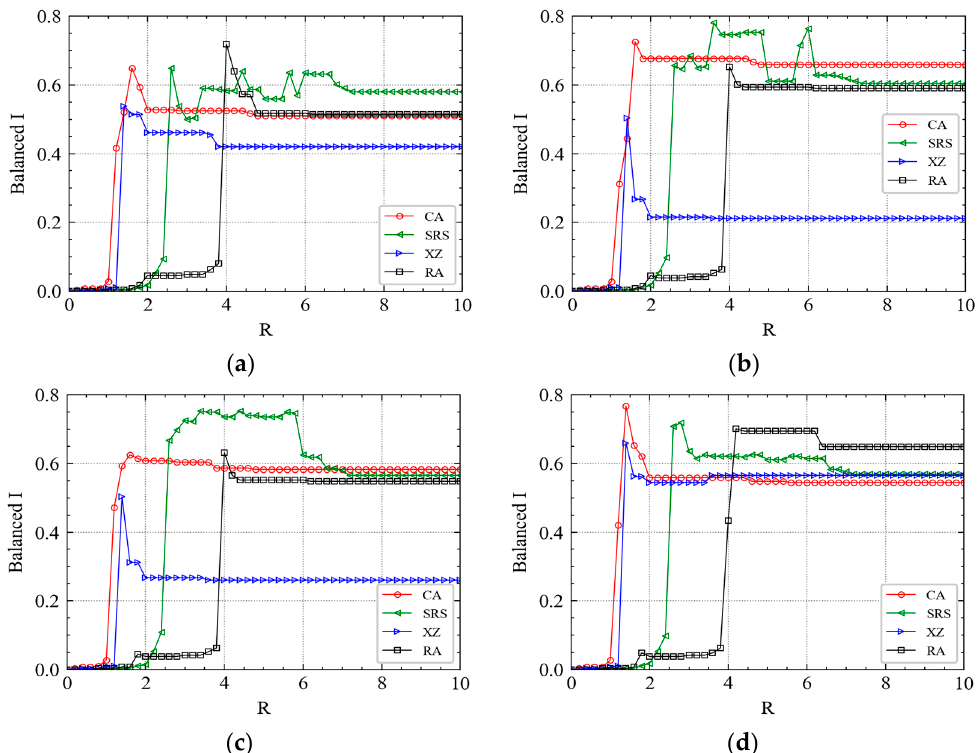
Figure 4. With the increase of R, the cumulative failure proportion of the system will get a balanced value under different attacks. ( a ) The morning peak of April’s first Wednesday. ( b ) The morning peak of April’s second Wednesday. ( c ) The morning peak of April’s third Wednesday. ( d ) The morning peak of April’s fourth Wednesday.